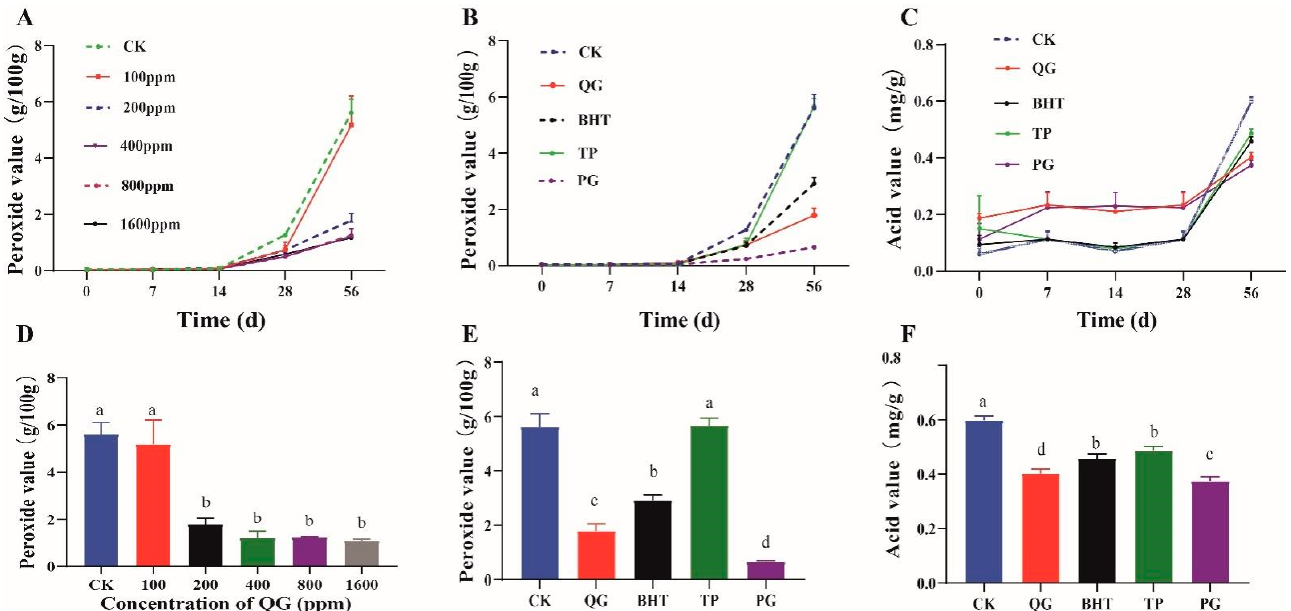
Figure 3. Mean peroxide value (PV) for pure soybean oil and oil treated with different concentrations (100, 200, 400, 800 and 1600 ppm) QG ( A ); mean peroxide value (PV) for pure soybean oil, QG and positive antioxidants with 200 ppm ( B ); mean acid value (AV) for pure soybean oil, QG and positive antioxidants with 200 ppm ( C ); mean PV in soybean oil treated with different concentrations QG after 56 days ( D ); mean PV in soybean oil treated with different antioxidants after 56 days ( E ); mean AV in soybean oil treated with different antioxidants after 56 days ( F ). Error bars represent the mean value ± SD. Significant differences between diet groups at the indicated week are signified by letters, where different letters indicate difference (P < 0.05) between groups, while the same letter indicates no difference..